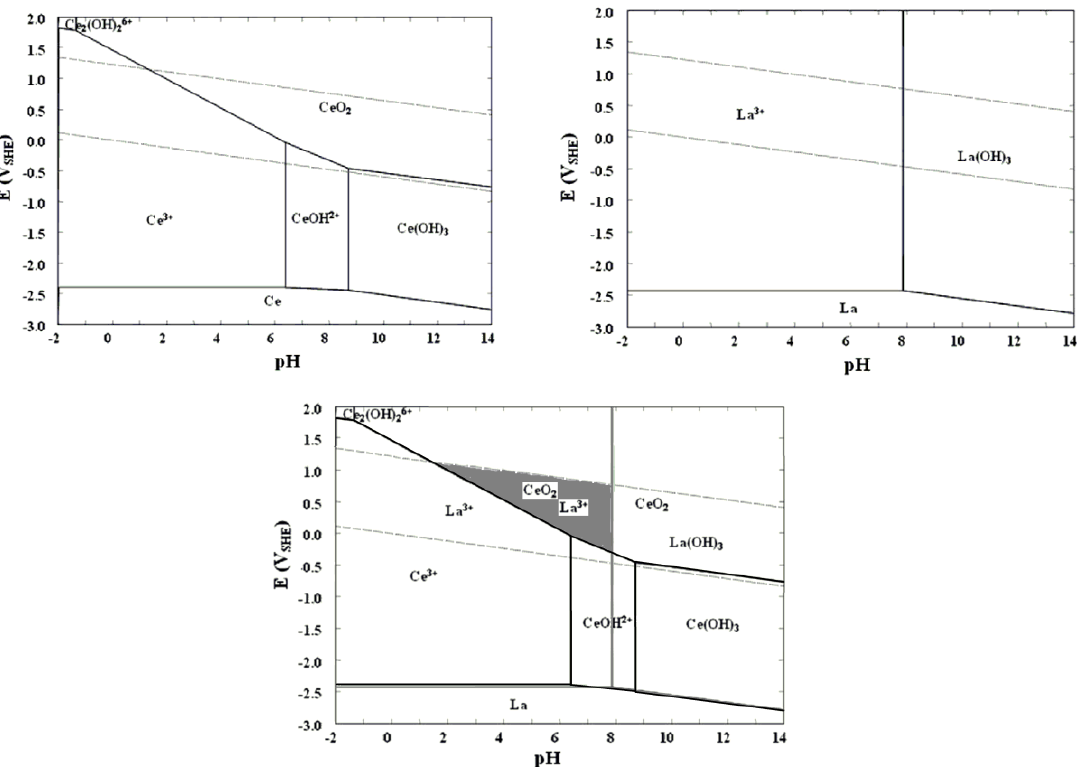
Figure 8. Individual and overlapped Pourbaix diagrams of cerium and lanthanum. The overlapped Pourbaix diagram of lanthanum (gray lines) and cerium (black lines) show the region where cerium can be selectively precipitated in aqueous solutions. La and Ce concentrations are 10 − 3 mol/L each. Reproduced and adapted from Kim and Osseo-Asare [52], with permission from Elsevier, 2018.